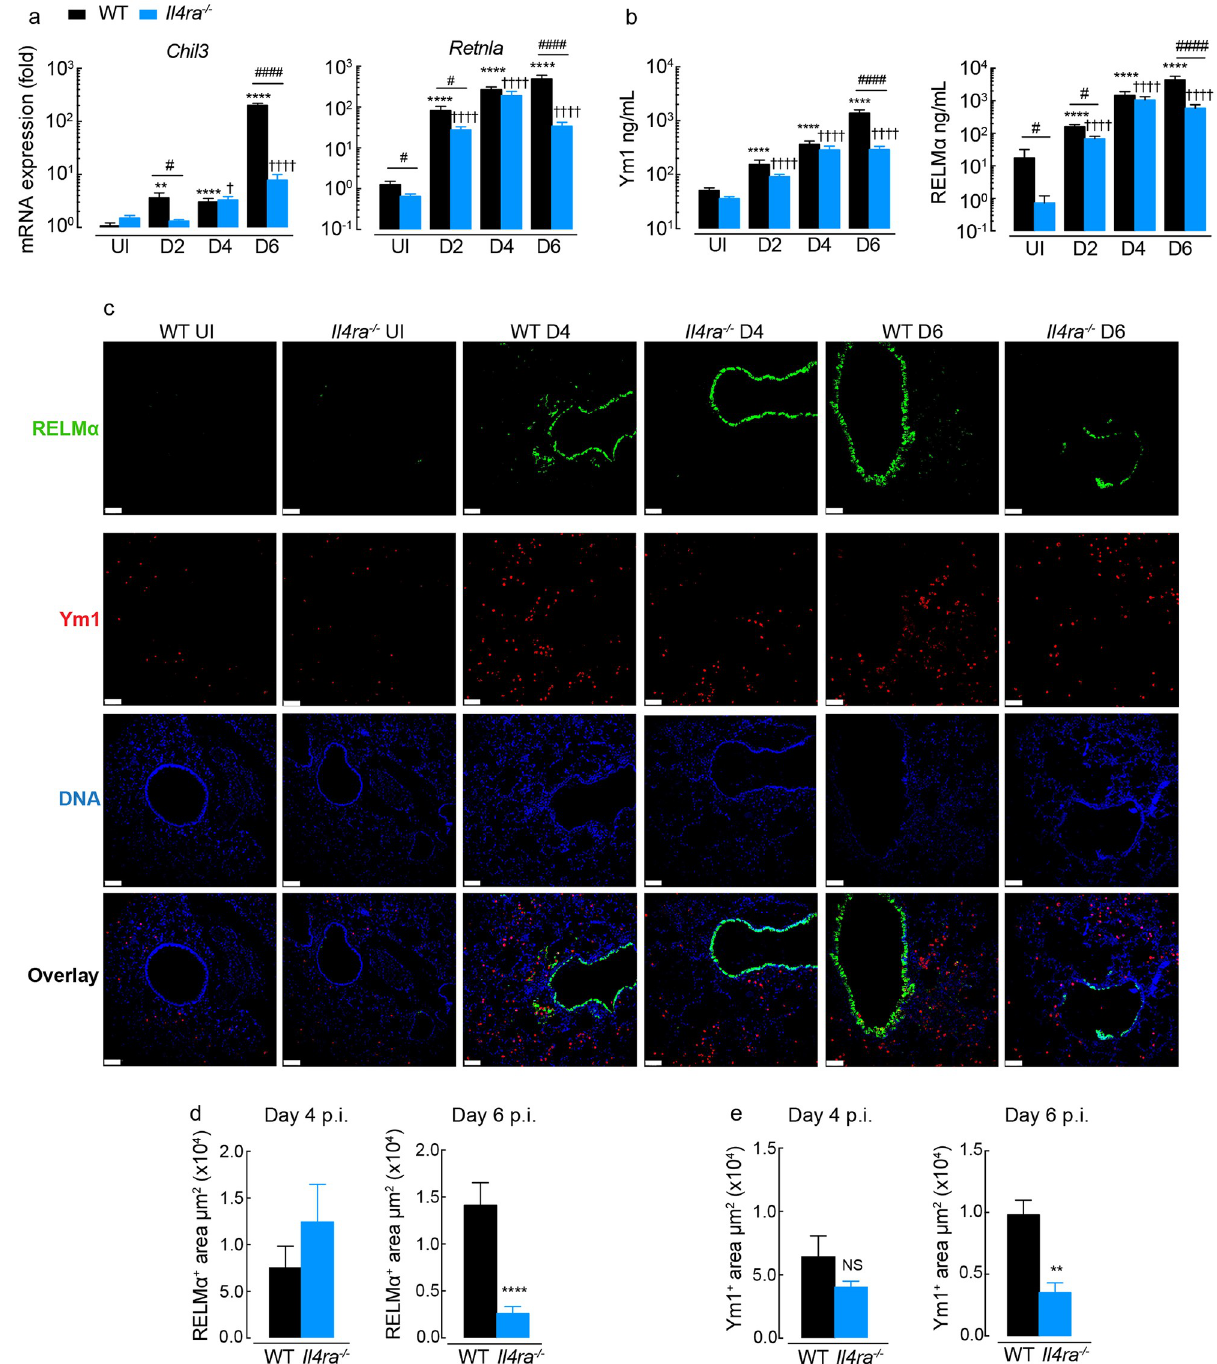
Fig 1. The expression of Ym1 and RELM α in the lungs of mice. (a) Amplification of Chil3 and Retnla mRNA in lung tissue from BALB/c WT or Il4ra -/- mice left uninfected (UI) or infected with N . brasiliensis (500 L3’s) and assessed at days 2, 4 and 6 post-infection (results are relative to uninfected WT, set as 1 (10 0 ); n = 12–6 per group; data are shown as mean ± sem; two-way ANOVA with Tukey multi-comparison test; NS not significant, ���� P < 0.0001 compared to UI wild-type (WT); ✝✝✝✝ P < 0.0001 compared to UI Il4ra -/-; #P < 0.05 and #### P < 0.0001 wild-type compared to Il4ra -/- mice; data pooled from 2 independent experiments). (b) Ym1 and RELM α levels in the BAL fluid from mice as in a . (c) Microscopy of lung sections from WT and Il4ra -/- BALB/c naive mice or mice infected with N . brasiliensis at day 4 and 6, stained with the DNA-binding dye (DAPI), blue; Ym1, red; and RELM α , green (scale bars, 70 μ m; images are representative of n = 6 of 2 independent experiments). ( d ) Quantification of the RELM α + areas in lung sections stained in c ( n = 6 per group; data are shown as mean ± sem; unpaired t test, ���� P < 0.0001; data representative of 2 independent